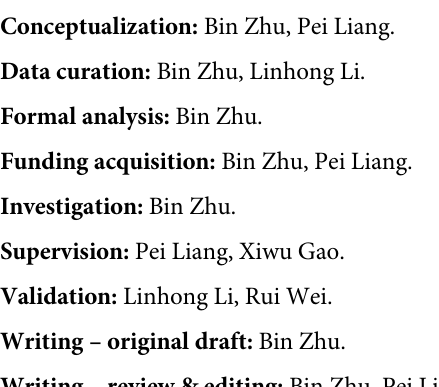
S2 Fig. The search for RNA-binding proteins using RNA binding protein immunoprecipi- tation (RIP). (TIF) S3 Fig. The miRNAs targeting GSTu1 predicted by miRanda and RNAhybrid. (TIF) S4 Fig. A schematic representation of all injection experiments. The upward and down arrows indicate that the expressions are up-regulated and down-regulated, respectively; The arrow with flat end indicates that the expression is unchanged. (TIF) S5 Fig. The standard curve used for quantification of chlorantraniliprole. (TIF) S1 Table. Toxicity of chlorantraniliprole to different populations of Plutella xylostella . (XLSX) S2 Table. Sequences of miR-8525-5p and miR-8530-5p agomir and antagomir. (XLSX) S3 Table. All primers used in this study.